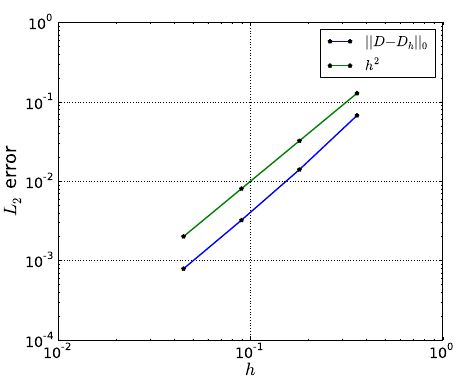
Fig. 12. k D − D h k 0 versus mesh size h (where D is the exact so- lution and D h is the numerical solution to the transport equation obtained using the method of Sect. 5.4). Second order convergence is observed as expected. Mass is conserved to machine precision (the maximum absolute conservation error is 1 . 7 × 10 − 14